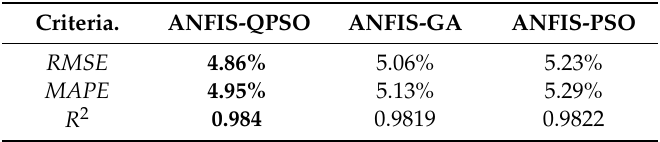
Table 11. PerformancecomparisonofANFIS-QPSO,ANFIS-GAandANFIS-PSOforthedryturningprocess.